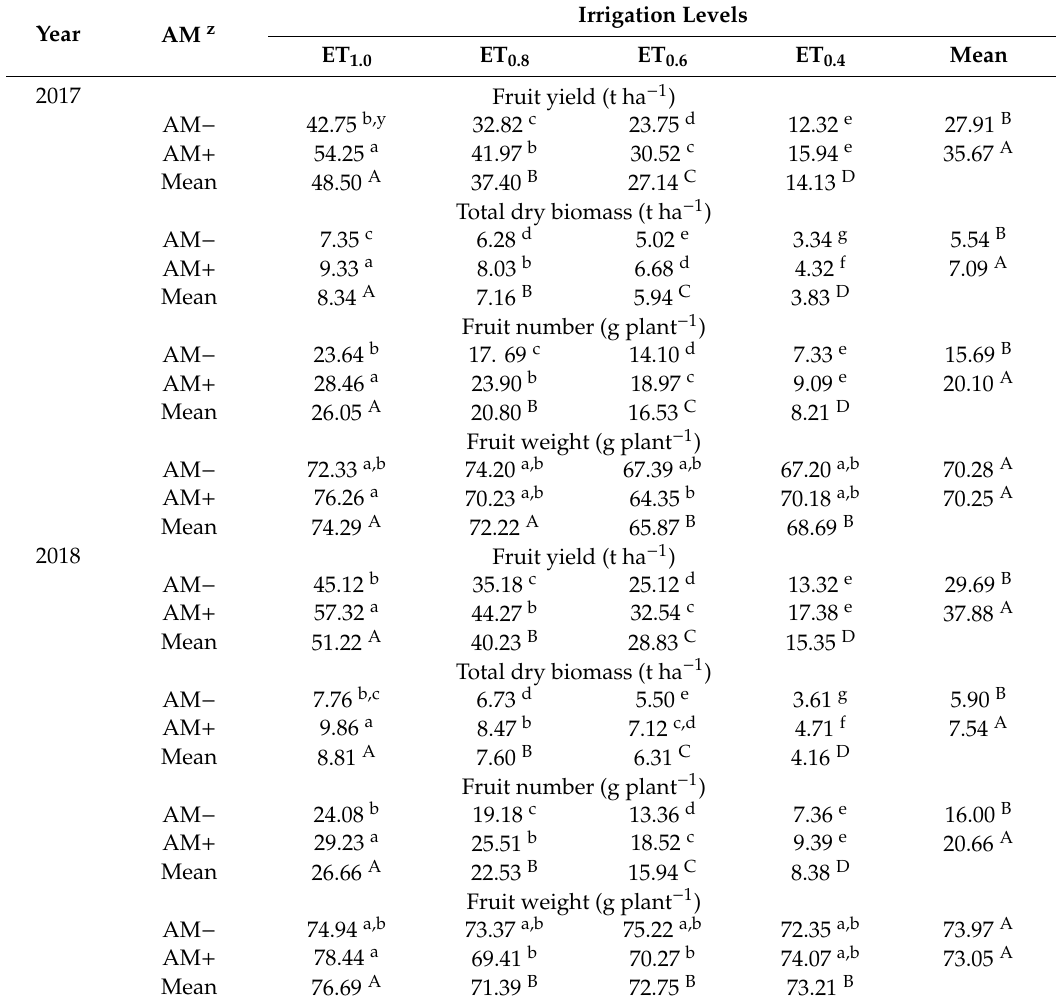
Table 2. Fruit yield, total dry biomass, fruit number, and fruit weight of eggplant subjected to varying water stress and AM